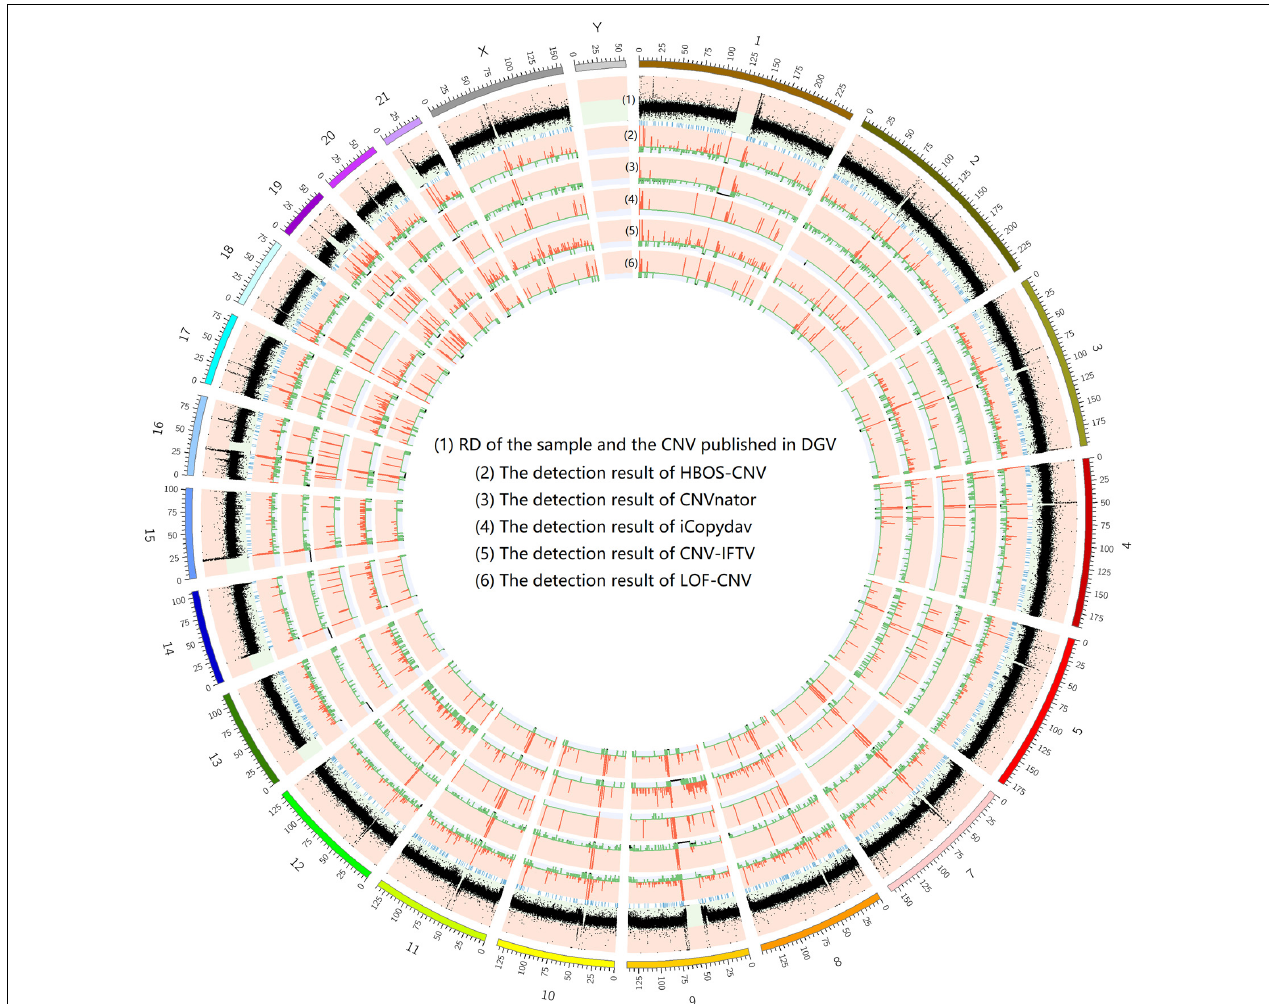
FIGURE 7 | The detection of all whole genomes of NA19238 is shown, with the circles representing (1) RD, and CNV published in DGV (2) the CNVs detected with HBOS-CNV, (3) the CNVs detected with CNVnator, (4) the CNVs detected with iCopyDav, and (5) the CNVs detected with CNV-IFTV, (6) the CNVs detected with LOF-CNV, from the outside to the